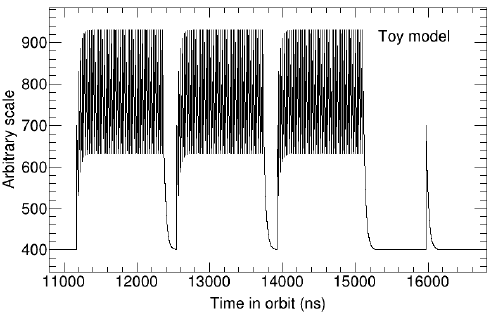
Figure 71. Illustration of the background increase during LHC bunch trains using a toy model, as described in the text. The increase in the background asymptotically reaches a constant level as observed in the data. The orbit time range from 10,800ns to 16,800ns corresponds to the LHC fill 6694. In this time range, one bunch train with two short gaps and one isolated bunch collision are modeled. Taken from Ref.